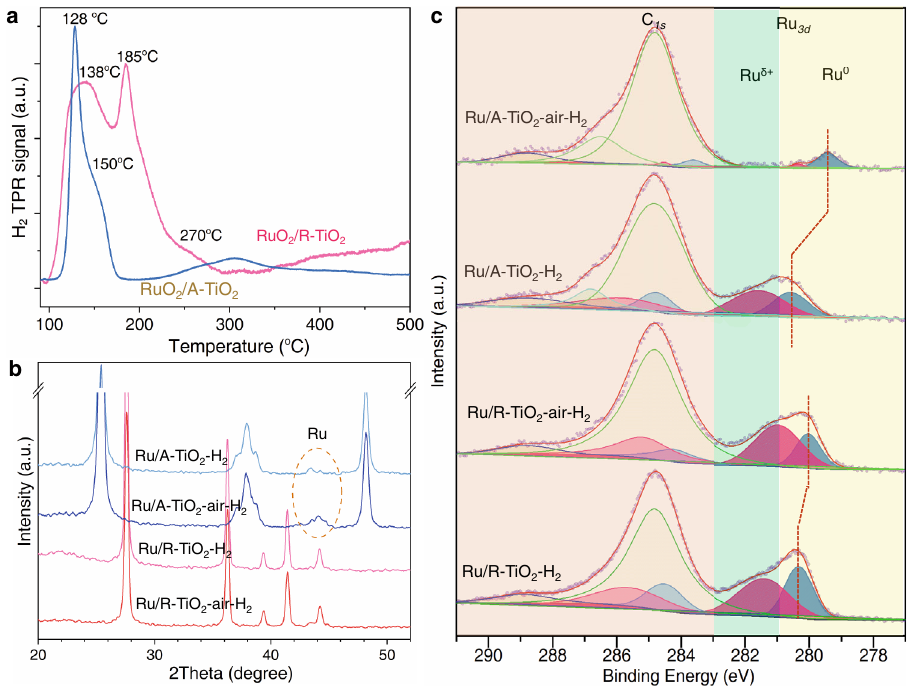
Fig. 3 Characterizing the chemical states of Ru species on TiO 2 supports. a H 2 -TPR of RuO 2 /A – TiO 2 and RuO 2 /R – TiO 2 . b XRD patterns and c XPS spectra of Ru/TiO 2 catalysts. Table 1 XPS results of 2% Ru/TiO 2